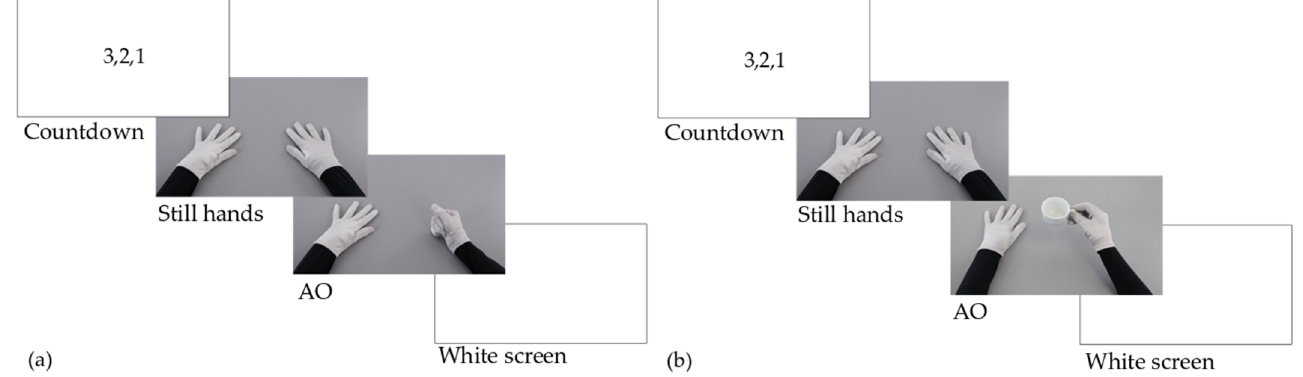
Figure 2. AOT treatment. Each video was preceded by a 2-s countdown and started with a 1-s image with still hands relaxed on a table. ( a ) Example intransitive action during AO: Hitting the table with a fist. ( b ) Example transitive action during AO: Grasping and lifting a teacup.